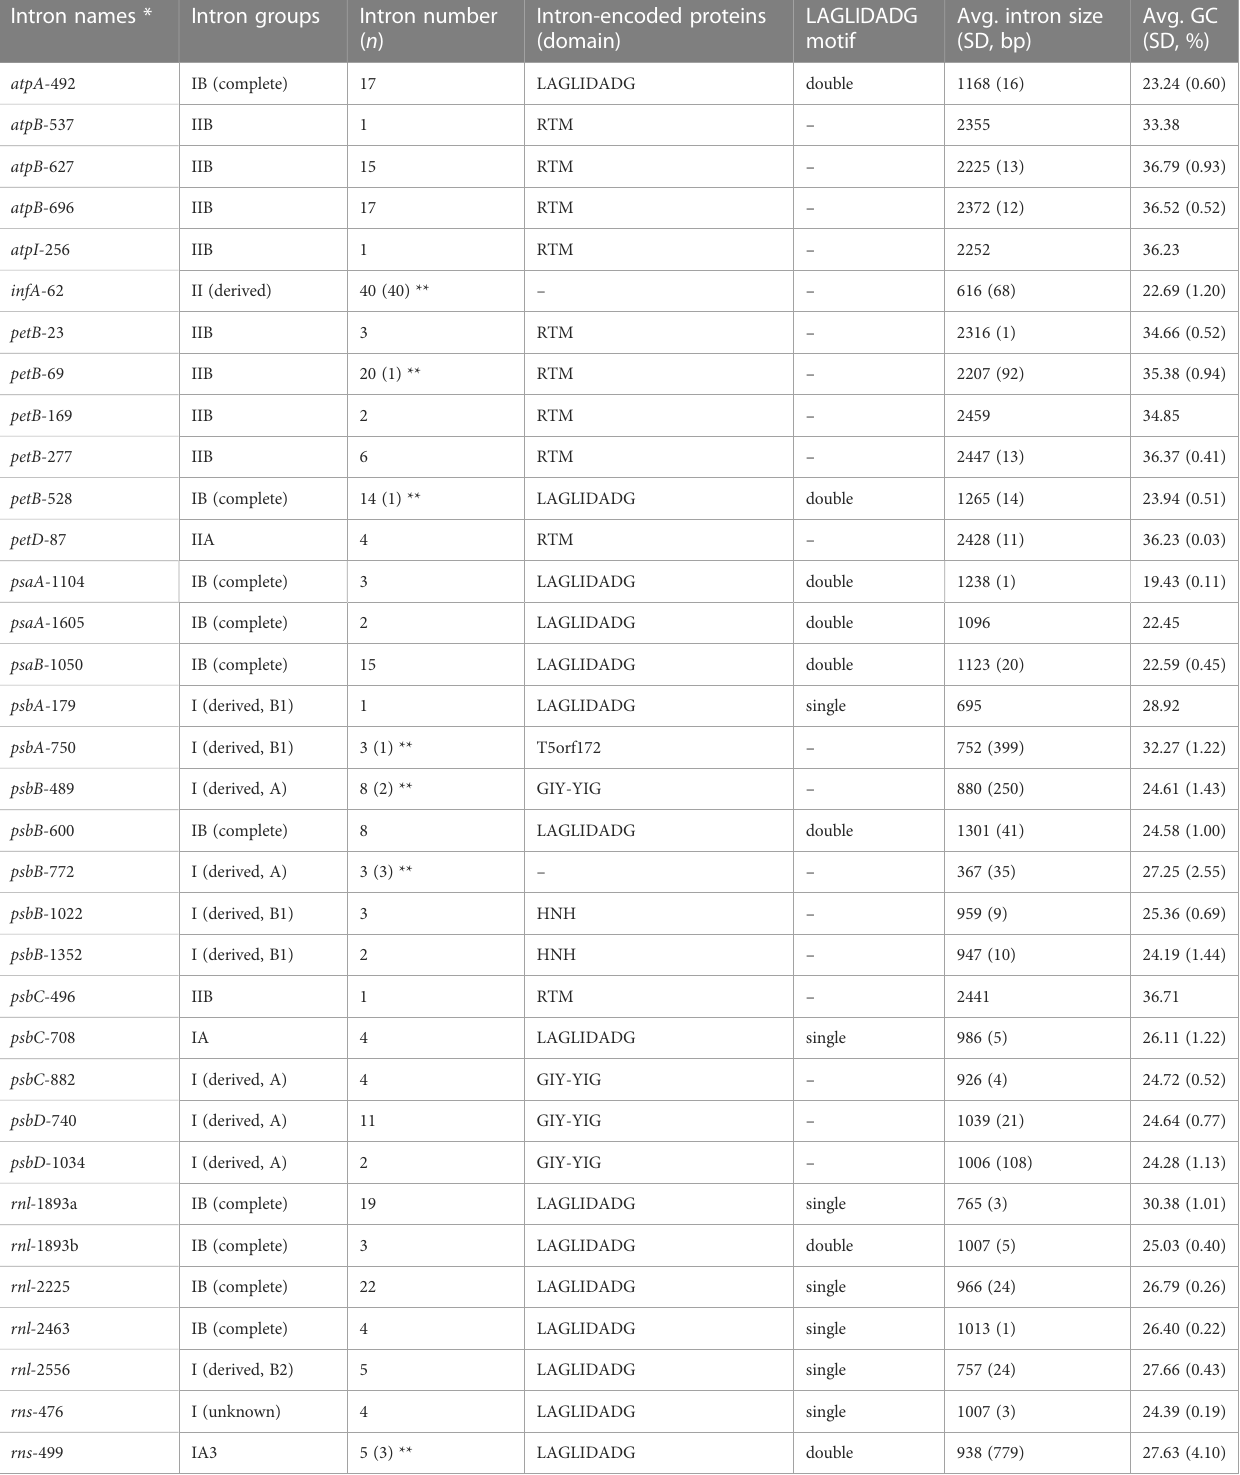
TABLE 2 General features of Ulva chloroplast introns detected among the 40 Ulva